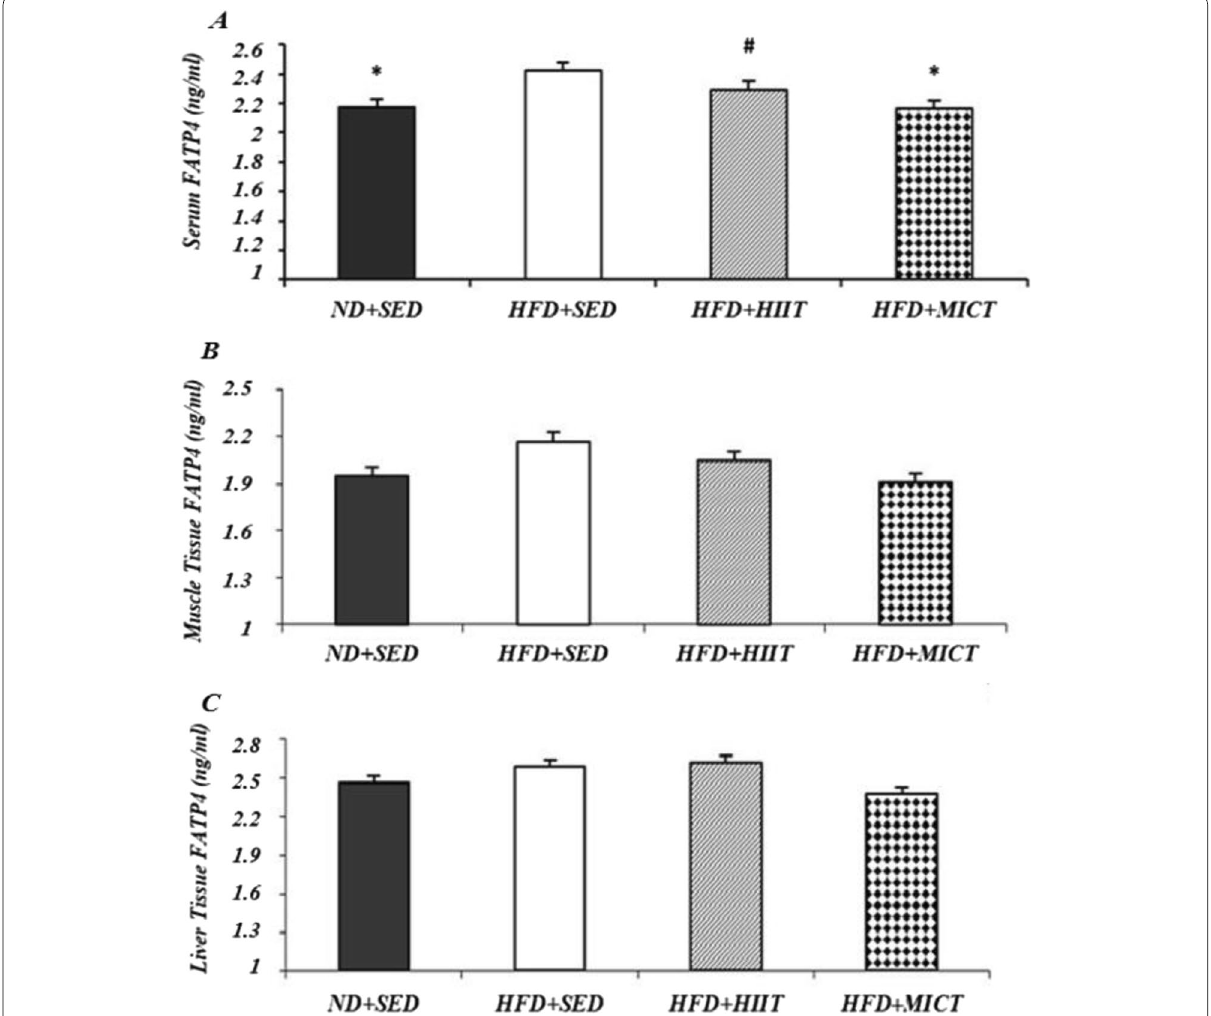
Fig. 3 A The comparison of serum FATP4 among the groups. * signs of significant difference with the HFD difference with the HFD MICT in p < 0.004. B The comparison of muscle tissue FATP4 among the groups. No significant difference was observed + among the groups. C The comparison of liver tissue FATP4 of among the groups. No significant difference was observed among the